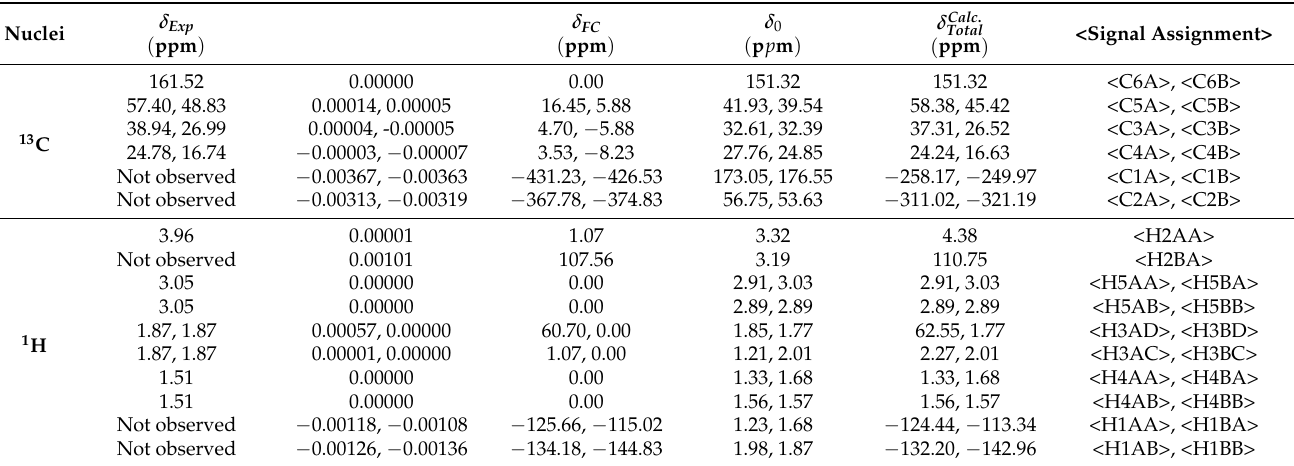
Figure 9. ( a ) Nomenclature for 1 H and 13 C chemical shifts assignation of compound [Cu(Citr) 2 ] n , and ( b ) Spin density of [Cu(Citr) 2 ] n calculated at the level of theory mPW1PW91/6-31G(d)-LANL2DZ and ECP=LANL2DZ. Table 7. Assignment of the 13 C and 1 H experimental and calculated hyperfine chemical shifts of the compound [Cu(Citr) 2 ] n obtained at the level of theory UmPW1PW91/6-31G(d)-LANL2DZ and